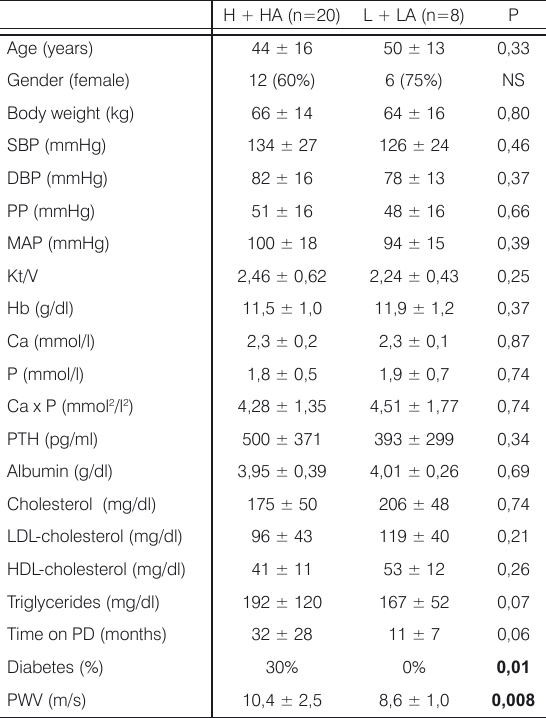
Table 2. Comparison of clinical and laboratory parameters between H/HA patients and L/LA patients.